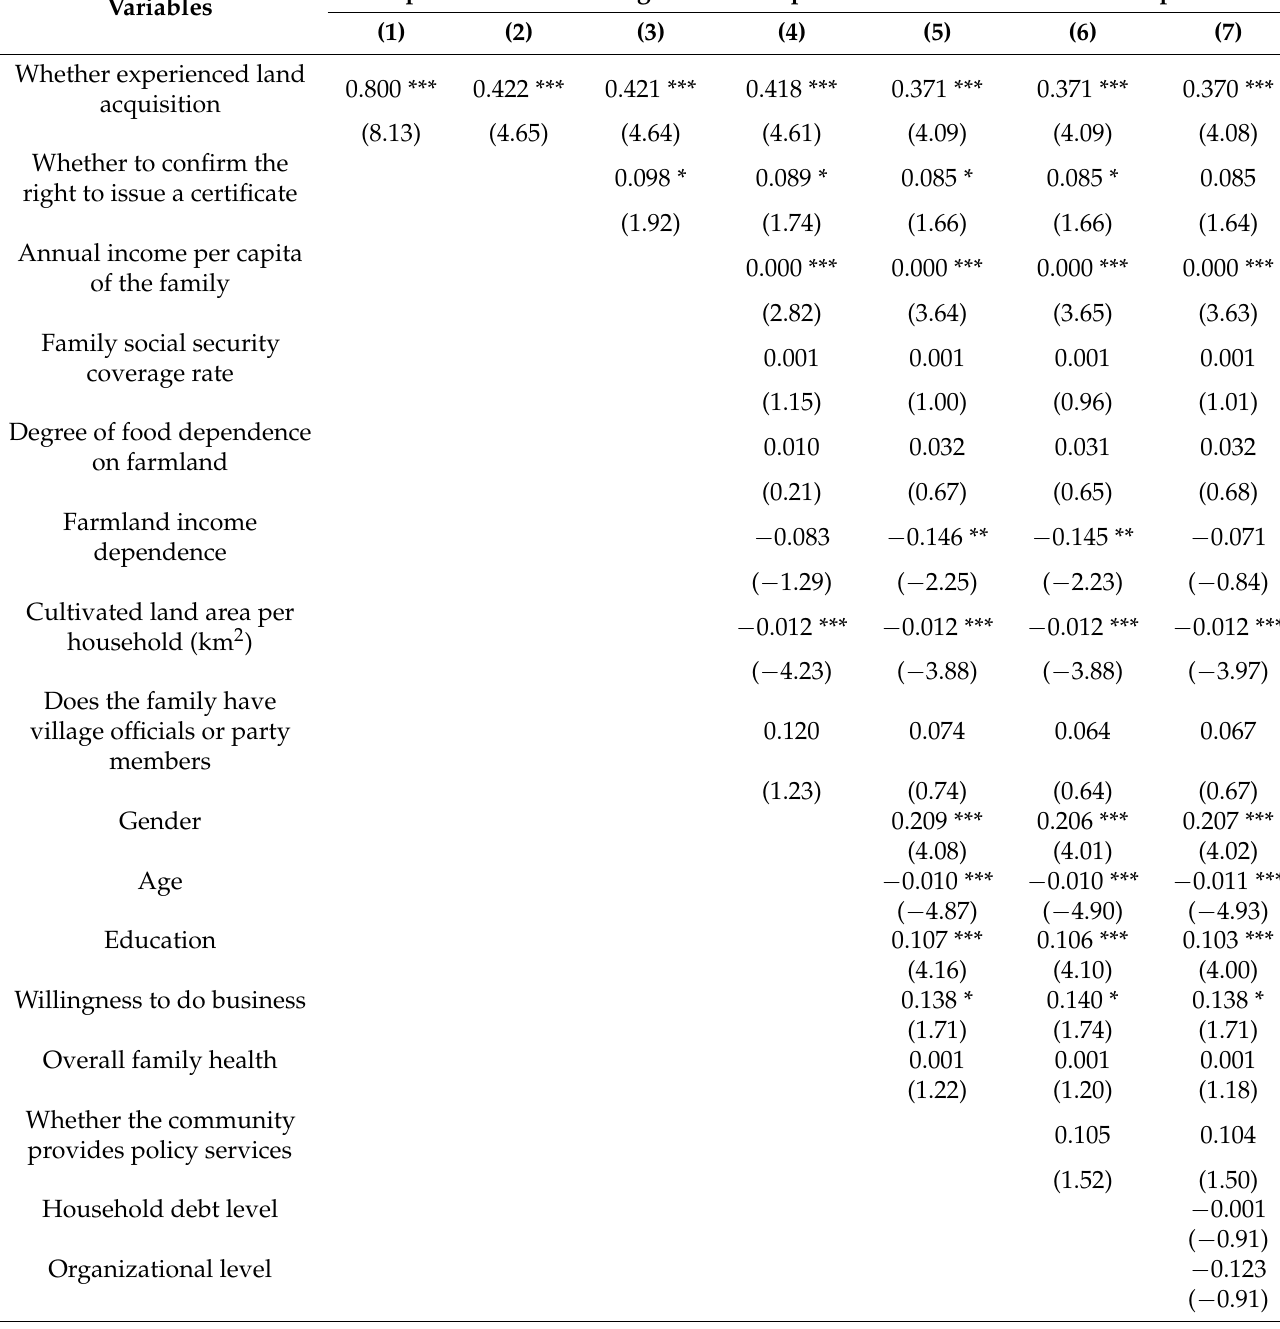
Table 5. Basic linear regression